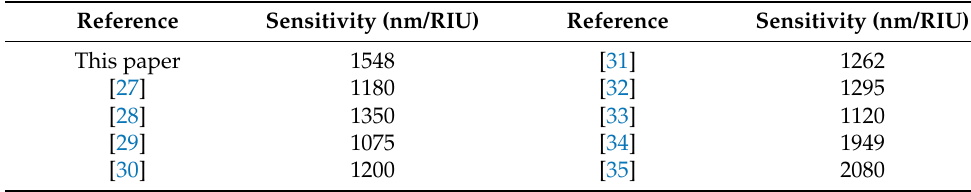
Table 1. Comparisons of results with other previous research.